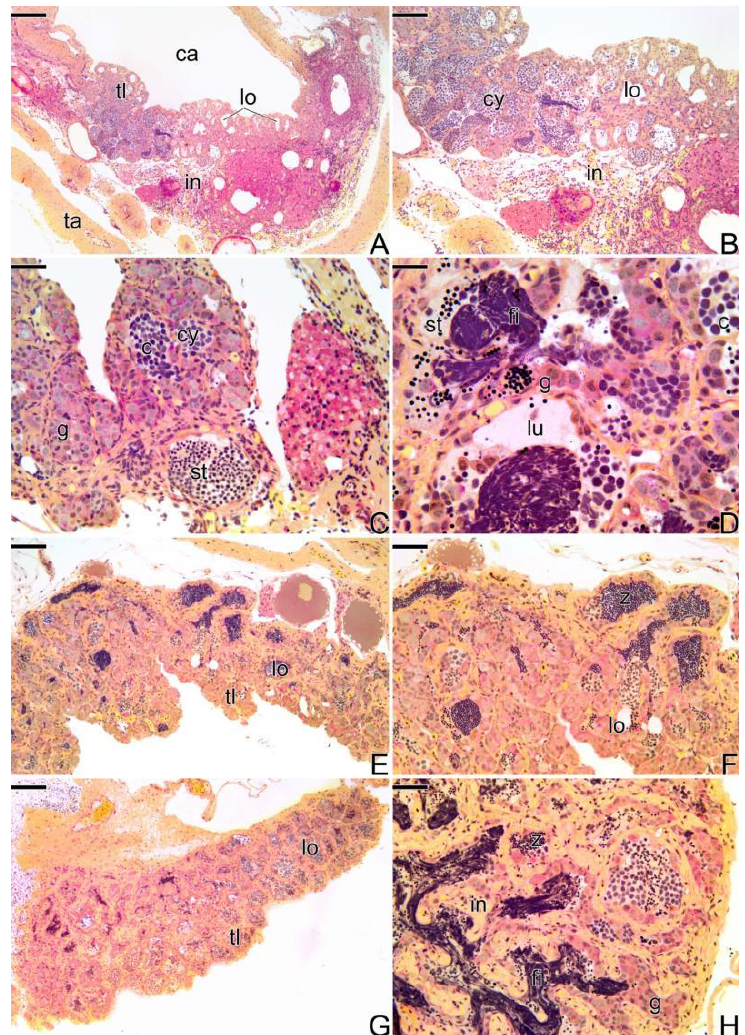
Figure 6. Histological sections of testes of secondary males of S. marmoratus . Note the progression of spermatogenesis, throughout the process of testicular development. Coelomic cavity (ca), interstitium (in), tunica albuginea (ta), testicular lamellae (tl), testicular lobules (lo), gemline cysts (cy), spermatocytes (c), spermatogonia (g), spermatids (st), basophilic filaments (fi), testicular lumen (lu). Staining: MY. Bar: 200µm ( A , E , G ), 100µm ( B ), 20µm ( C ), 15µm ( D ), 30µm ( F ).